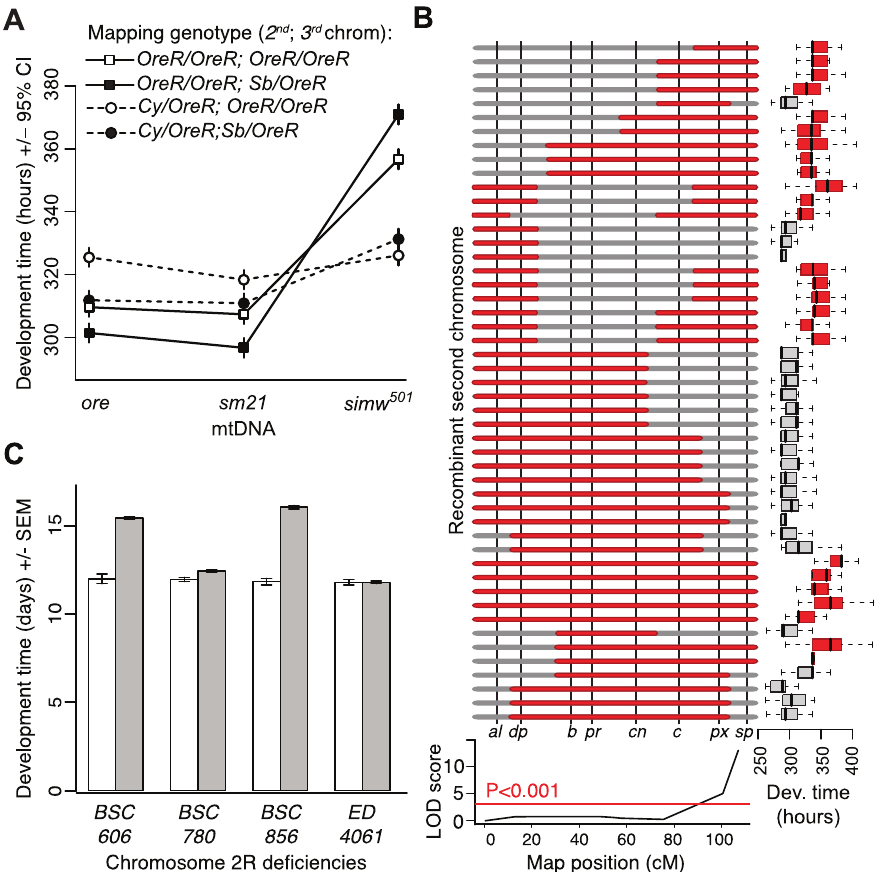
Figure 4. Genetic mapping implicates an interaction between the mt-tRNA Tyr and its nuclear-encoded mt-TyrRS. (A) Chromosome segregation mapping using dominant, visible markers on the second and third chromosomes ( Cy and Sb , respectively) revealed that the developmental delay is caused by a largely recessive factor on the OreR second chromosome. Only flies homozygous for the OreR second chromosome (squares) have extended development time. (B) Meiotic mapping using visible markers on the second chromosome indicates that flies with the simw 501 mtDNA that are homozygous for the OreR second chromosome (red) at the marker speck ( sp ) take significantly longer to develop than flies with the simw 501 mtDNA that are heterozygous for OreR and the mapping chromosome allele at this marker (gray), resulting in a significant marker-trait association (LOD score). (C) Two overlapping chromosomal deficiencies ( BSC606 and BSC856 ) at the tip of Chromosome arm 2R fail to complement the OreR nuclear factor and significantly extend development time when combined with the simw 501 mtDNA ( P ANOVA , 0.0001, both deficiencies). Two neighboring deficiencies ( BSC780 and ED4061 ) complement the nuclear factor and restore development time to that of controls. Gray bars represent mean development time of ( simw 501 ); OreR individuals inheriting the deficiency chromosome and white bars are control siblings inheriting a compatible balancer chromosome. The effects of these deficiencies are independent of sex, require the simw 501 mtDNA (Figure S2), and implicate Aatm , the only gene contained in both BSC606 and BSC856 with annotated mitochondrial function. the cytosolic ribosomes and are putatively unable to satisfy the protein synthesis demands of rapid growth during development [43,44]. Other mutations that compromise cytoplasmic protein synthesis in D. melanogaster , such as those in the cytoplasmic aaRSs, also compromise bristle formation [45]. Our results demonstrate that disrupting the mitochondrial translational machinery pheno- copies the Minute mutations, indicating that efficient mitochondrial function is required to energetically support cytoplasmic protein synthesis during larval growth and metamorphosis. Defective